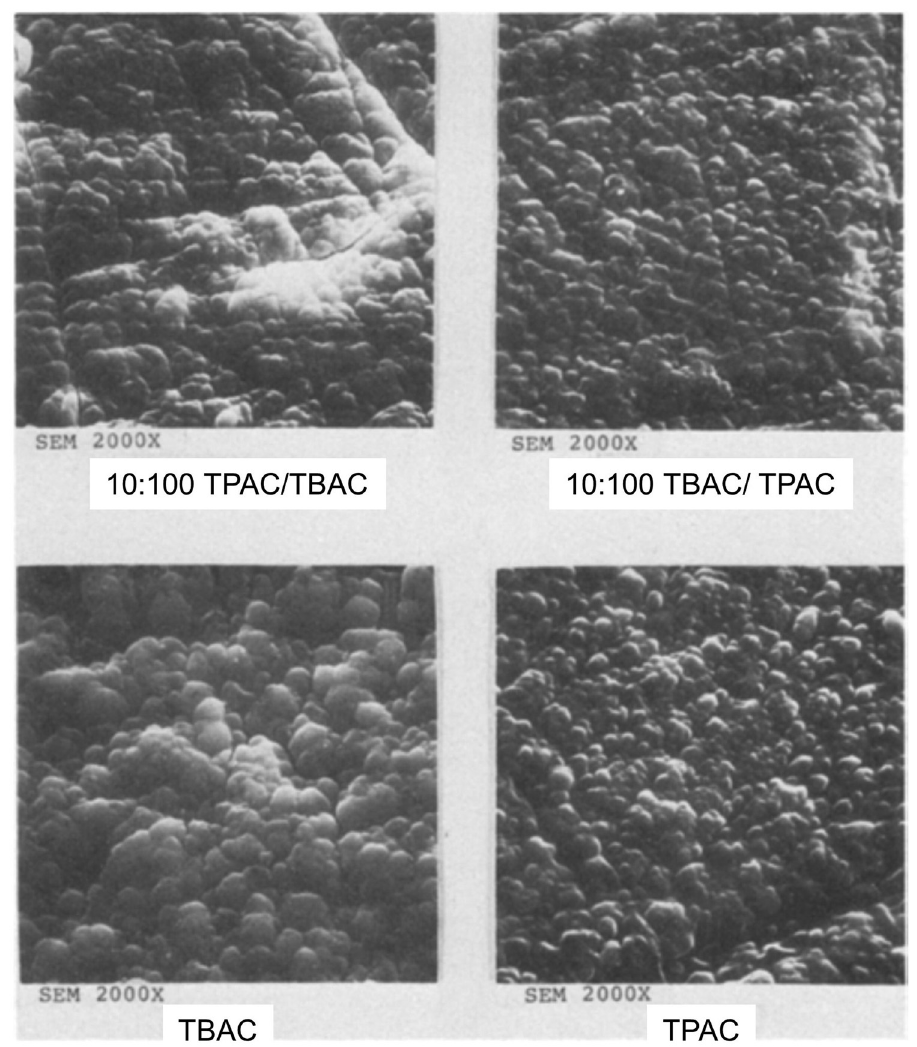
Figure 9: Surface SEM images of the Si fi lms electrodeposited at 323 K in PC containing 1.0 M SiHCl 3 and various amount of TBAC and TPAC [ 171 ] . Permission from Electrochemical